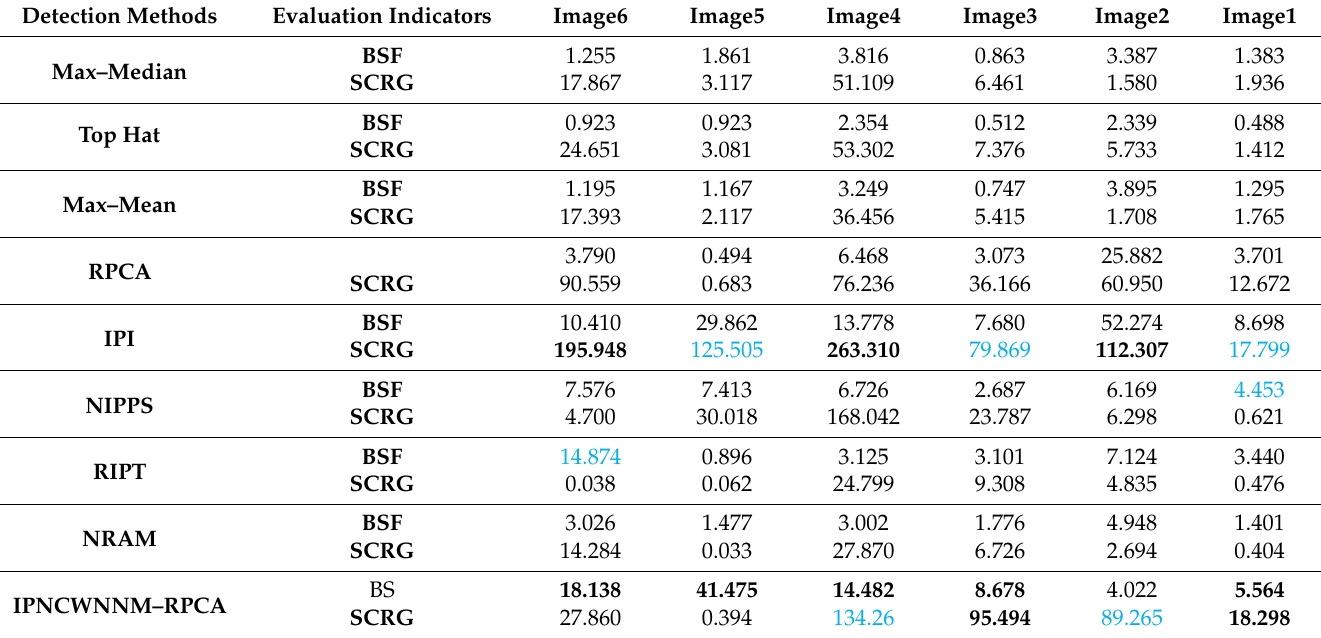
Table 6. SCRG values for the test images shown in Figure